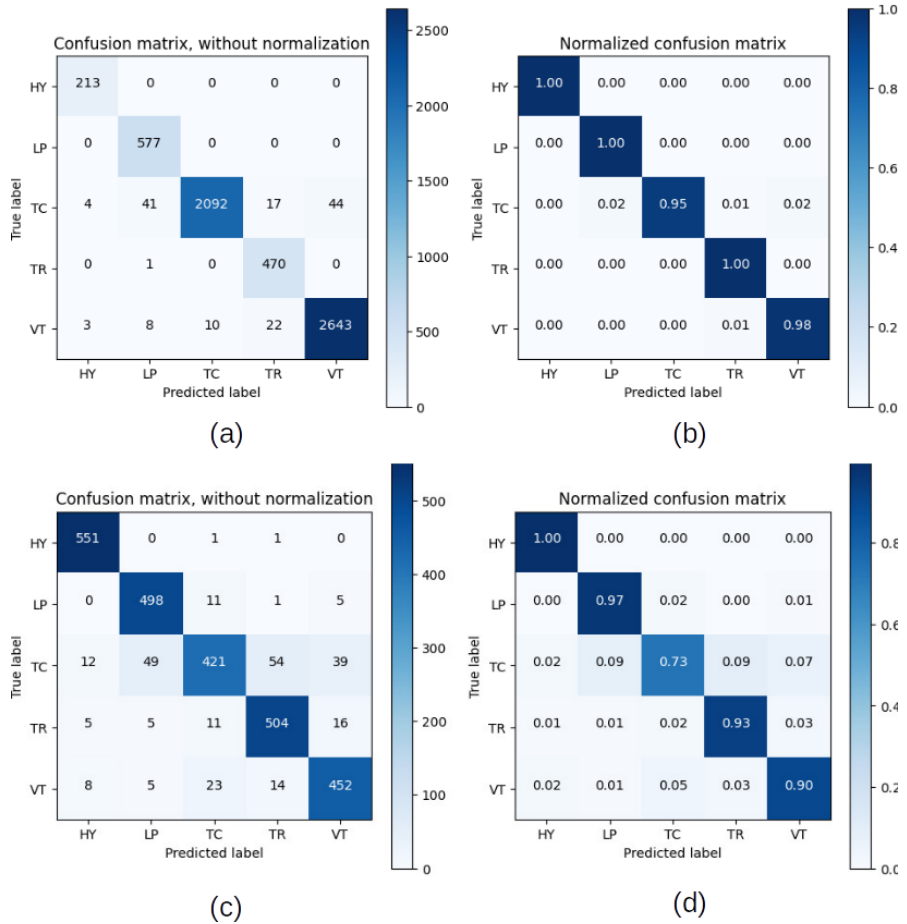
Figure 10. Confusion matrices without normalization (a) and normalized (b) , for experiment (iii), and without normalization (c) and nor- malized (d) , for experiment (iv).